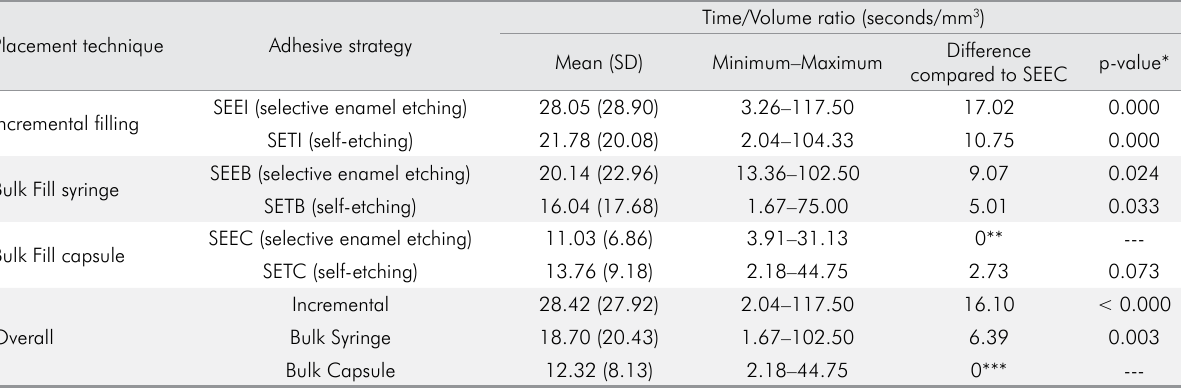
Table 3. Description of the time/volume ratio (seconds/mm 3 ) to perform the restorative procedures among the experimental groups. Placement